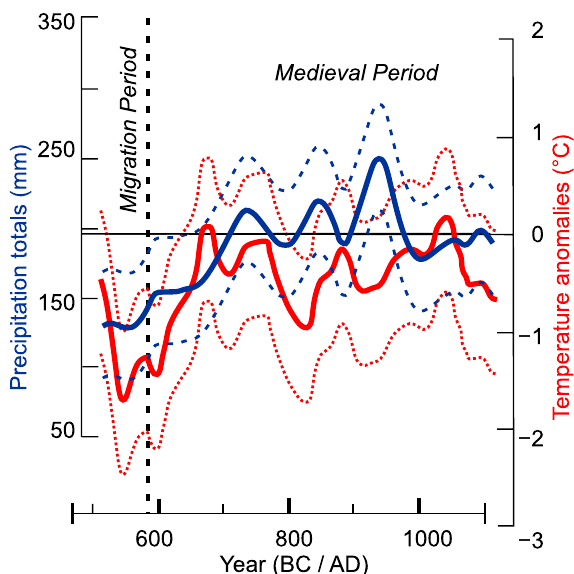
Fig. 2. Amount of precipitation and temperature anomalies in the Middle Ages after Büntgen et al. (2011) –